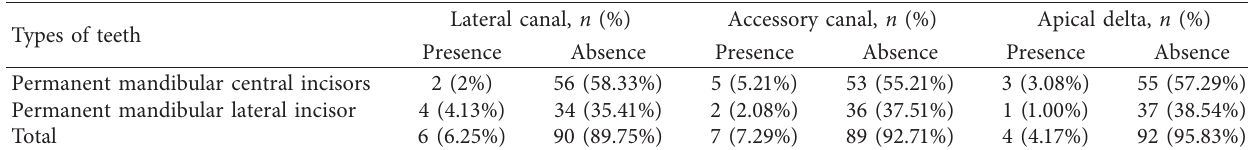
Table 5: Distribution of lateral canal, accessory canal, and apical delta in mandibular central and lateral